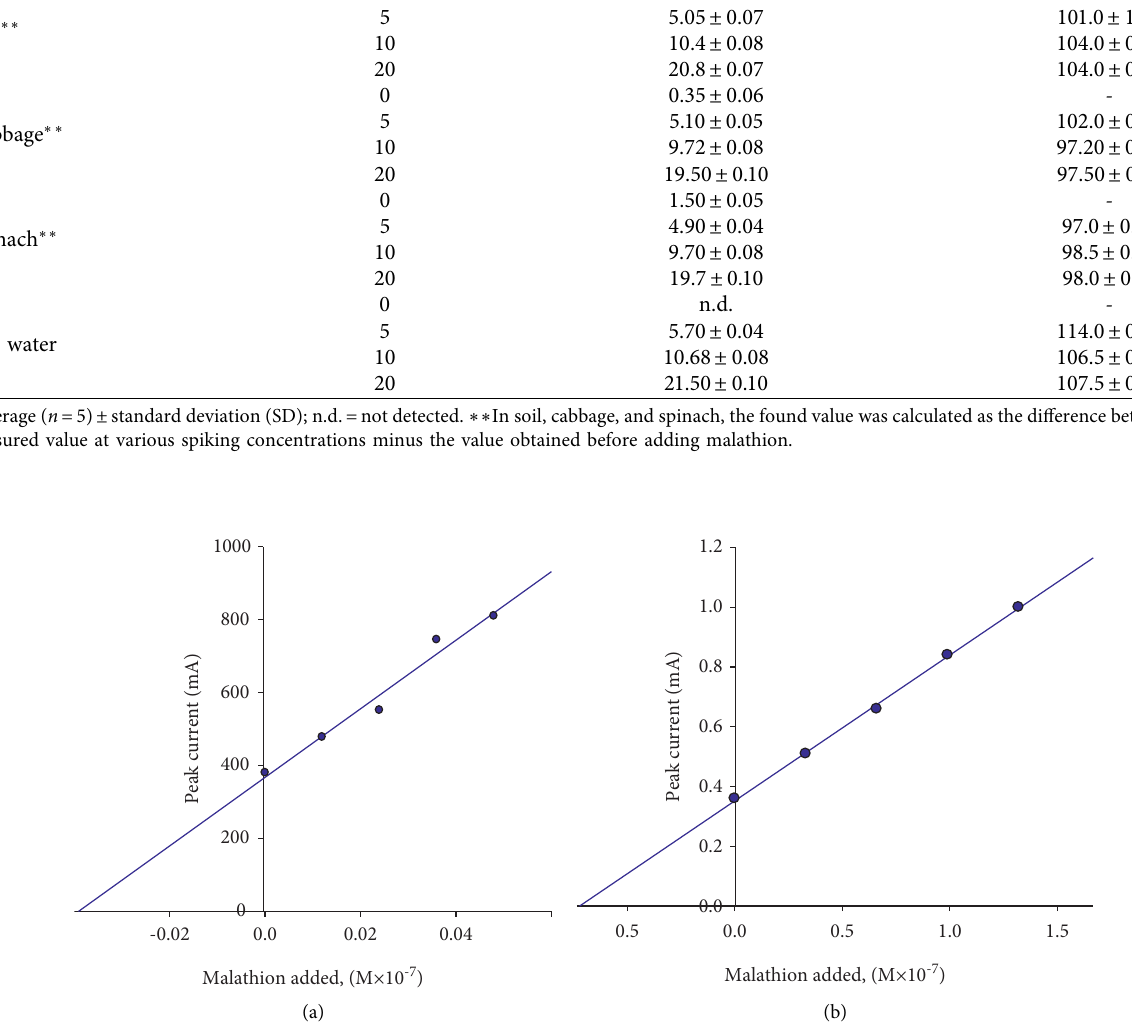
Figure 6: Standard addition SW-CSVs for the determination of malathion and Cu 2+ ions at pH 2 under the optimized parameters in soil (a) and cabbage (b) at HMDE. Deposition and staring potential − 0.2 V, accumulation time 360 s scan rate � 100 mV/s, pulse ampli- tude � 50 mV, and frequency 60